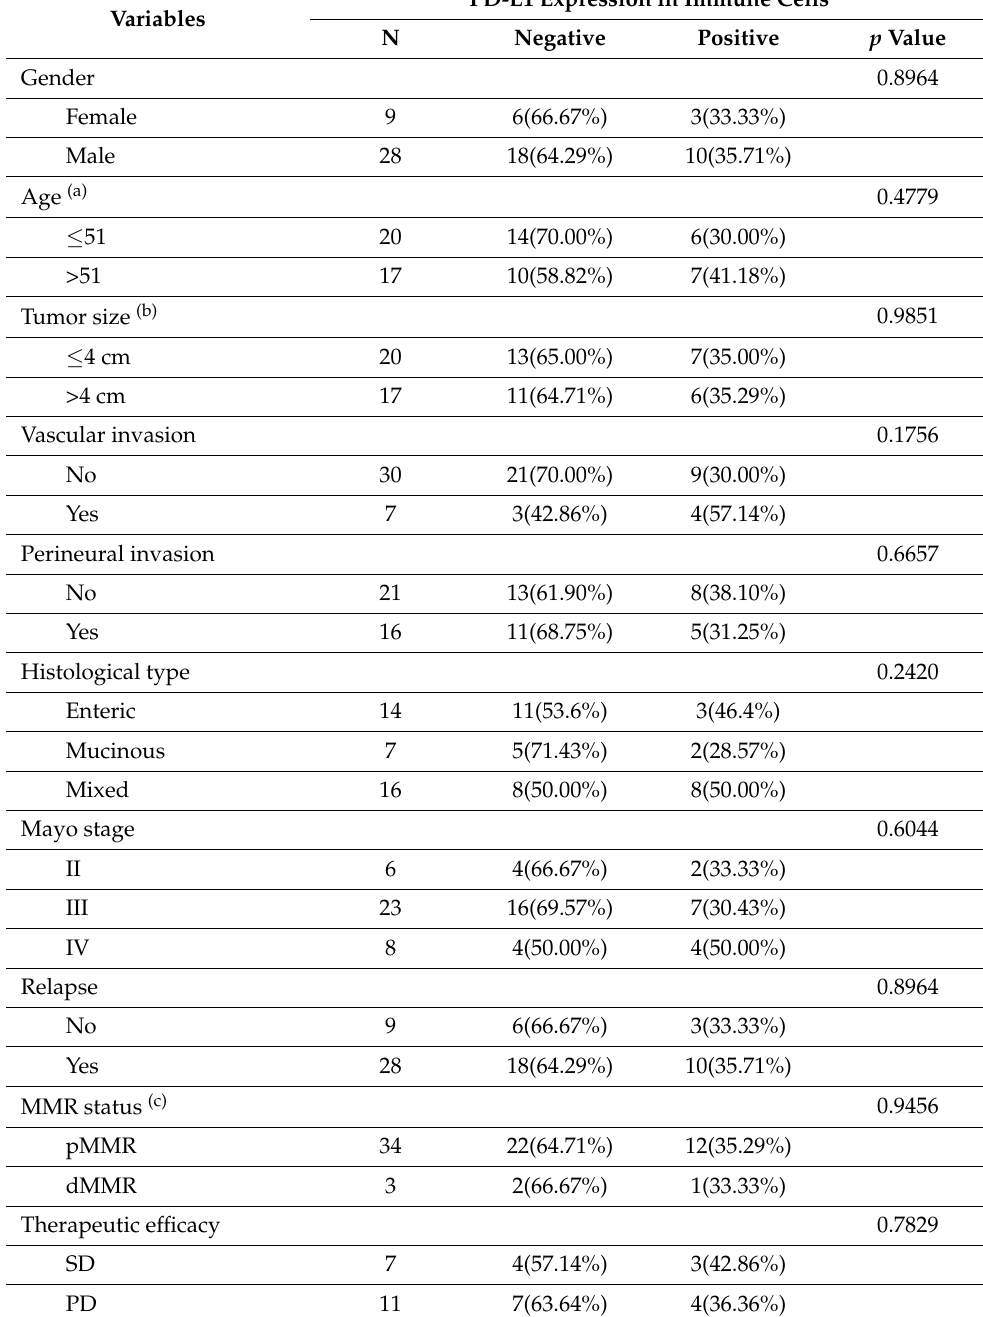
Table 4. Correlation between the PD-L1 expression in immune cells and clinicopathological variables in